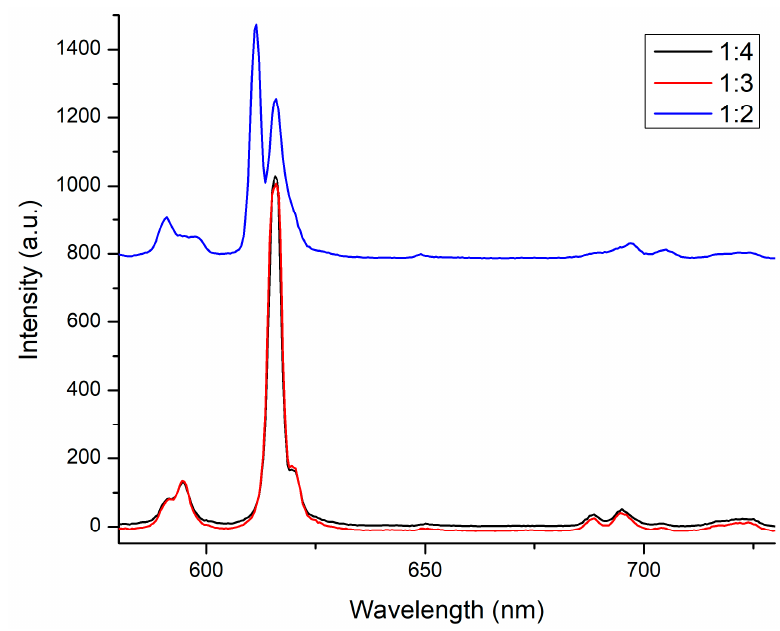
Figure 4. Fluorescence spectra comparison (europium centered region, excitation at 360 nm) in DMSO between Eu 3+ / L 12 − in 1:2 (blue), 1:3 (red) and 1:4 (black) molar ratios. At 1:2 molar ratio, the predominance of [Eu(L 1 ) 2 ] − was clearly confirmed by the aspect of both 5 D 0 → 7 F 1 and 5 D 0 → 7 F 2 bands with a higher multiplicity (with respect to the other